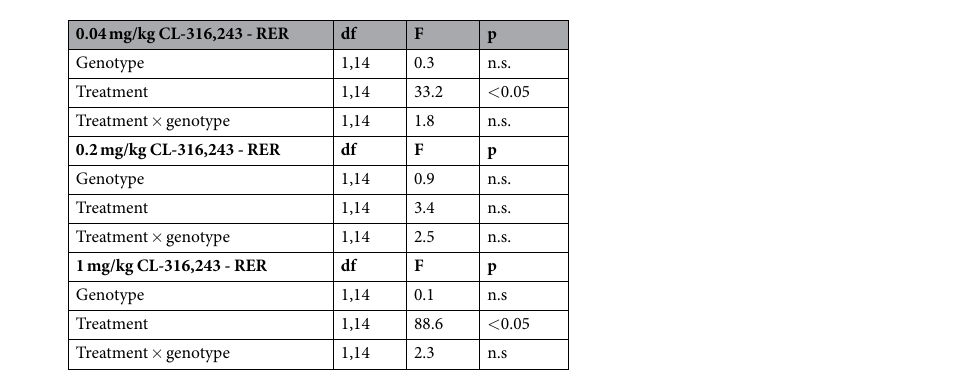
Table 7. Effects of CL-316,243 on respiratory exchange ratio in WT and UCP-1 KO mice – statistical results.